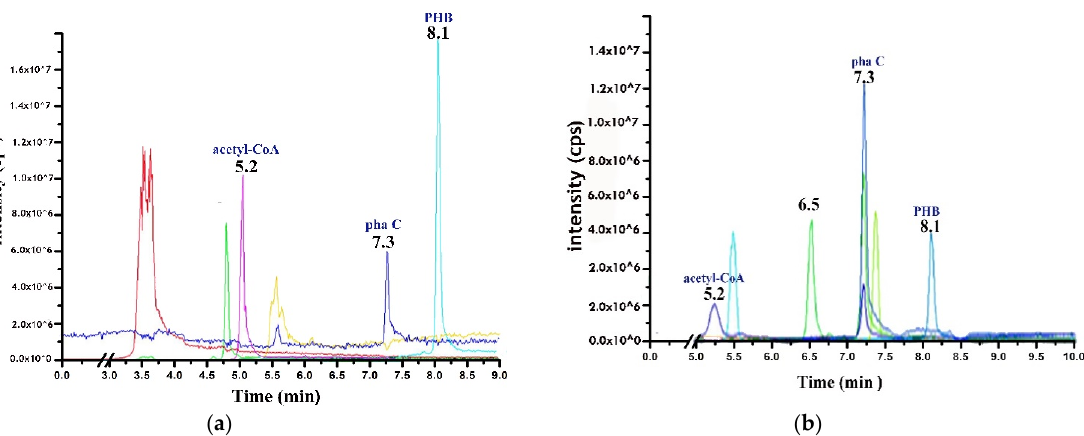
Figure 7. Spectrum from LC-MS/MS analysis of extracted PHB granules from ( a ) NRS_35 and ( b ) NRS_38 .